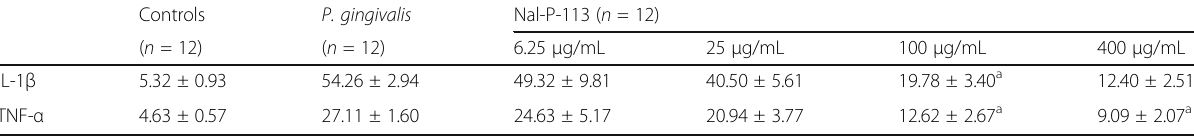
Table 2 Integrated optical densities of the immunohistochemical staining for IL-1 β and TNF- α Controls